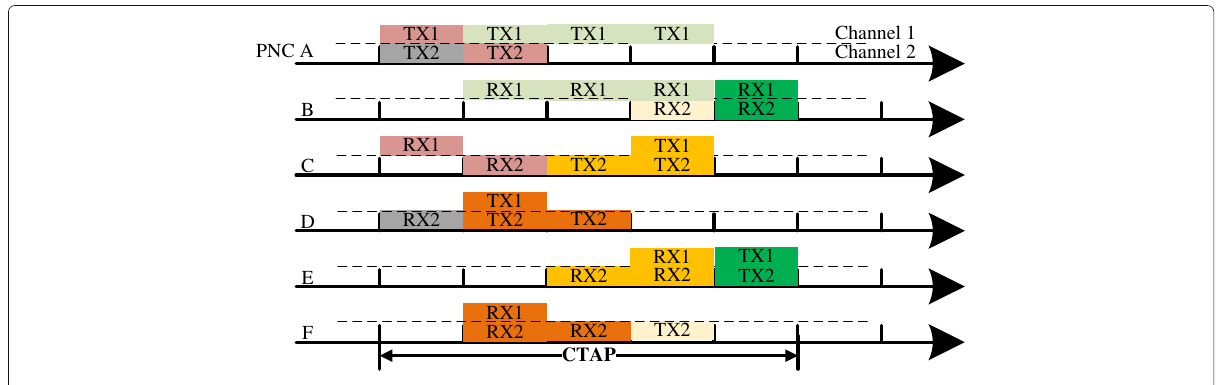
Fig. 2 An example of MPMH-MRMC operation applying MILP